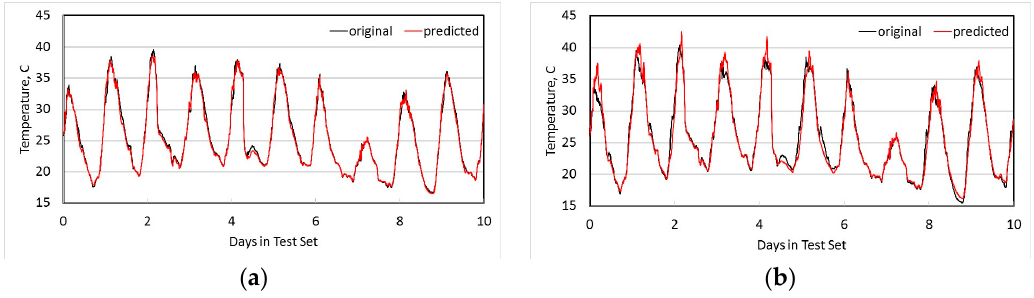
Figure 6. Estimation of temperature nodes N4 and N7. ( a ) N4 estimated from N7; ( b ) N9 estimated from N11.